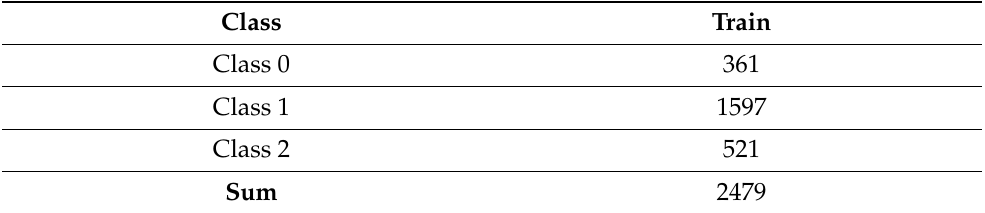
Table 4. Number of observations in the training dataset after the combination of images was applied to original